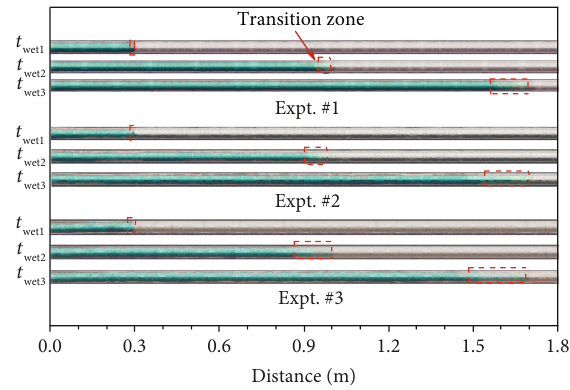
Figure 2: Visual imaging of the in fi ltration process in Expts. #1-#3. All snapshots show the general distribution of the saturated zone (red dotted line), transition zone (green dotted line), and unchanged zone (yellow dotted line) at the times that the wetting front reaches the positions P -P 1 3